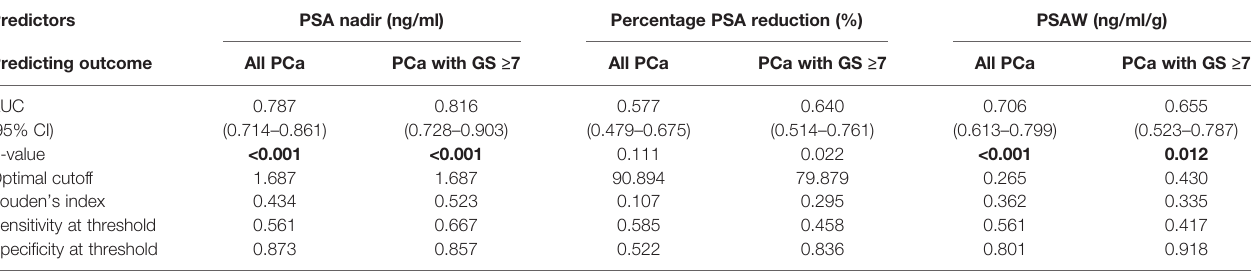
TABLE 2 | Prediction models: all prostate cancers or prostate cancers with GS ≥ 7 using post-TUEP PSA derivatives. Predictors Predicting